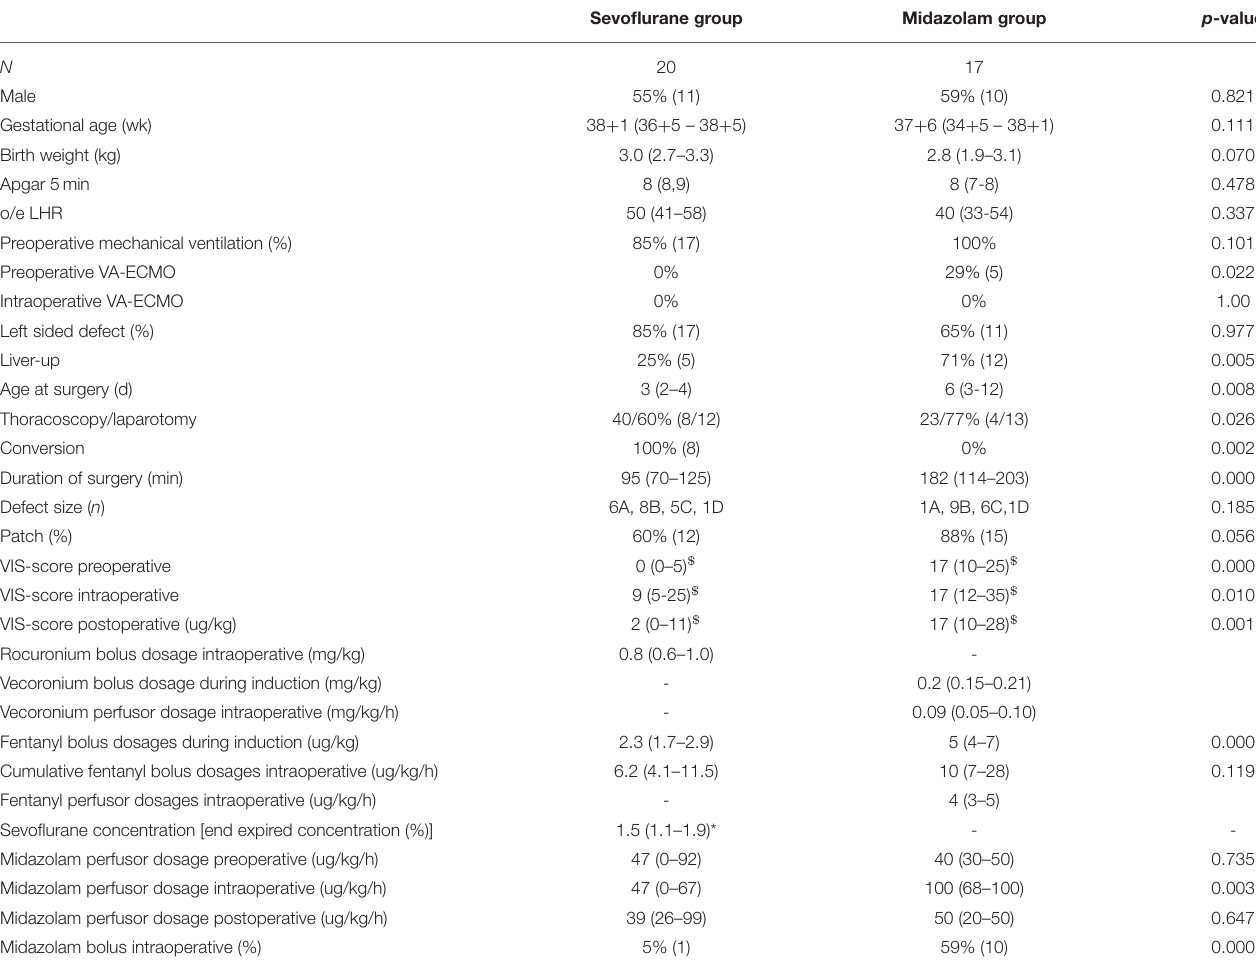
TABLE 1 | Patient demographics of the sevoflurane and the midazolam group.